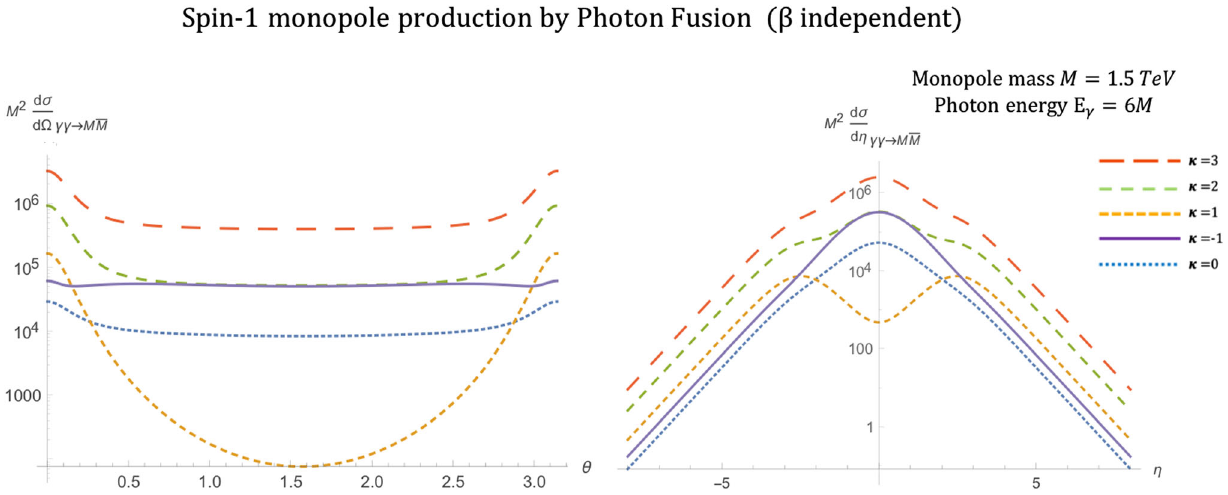
Fig. 15 Angular distributions for monopole-antimonopole pair pro- various values of the phenomenological parameter κ . The case κ = 1 duction via PF for the case of a monopole with spin 1 and mass represents the SM expectation for the pair production of spin-1 W ± M = 1 . 5 TeV as a function of the scattering angle θ (left) and the gauge bosons and is distinctive as the only unitary and renormalisable √ s γγ = 2 E γ , where E γ = 6 M , and for pseudorapidity η (right) at